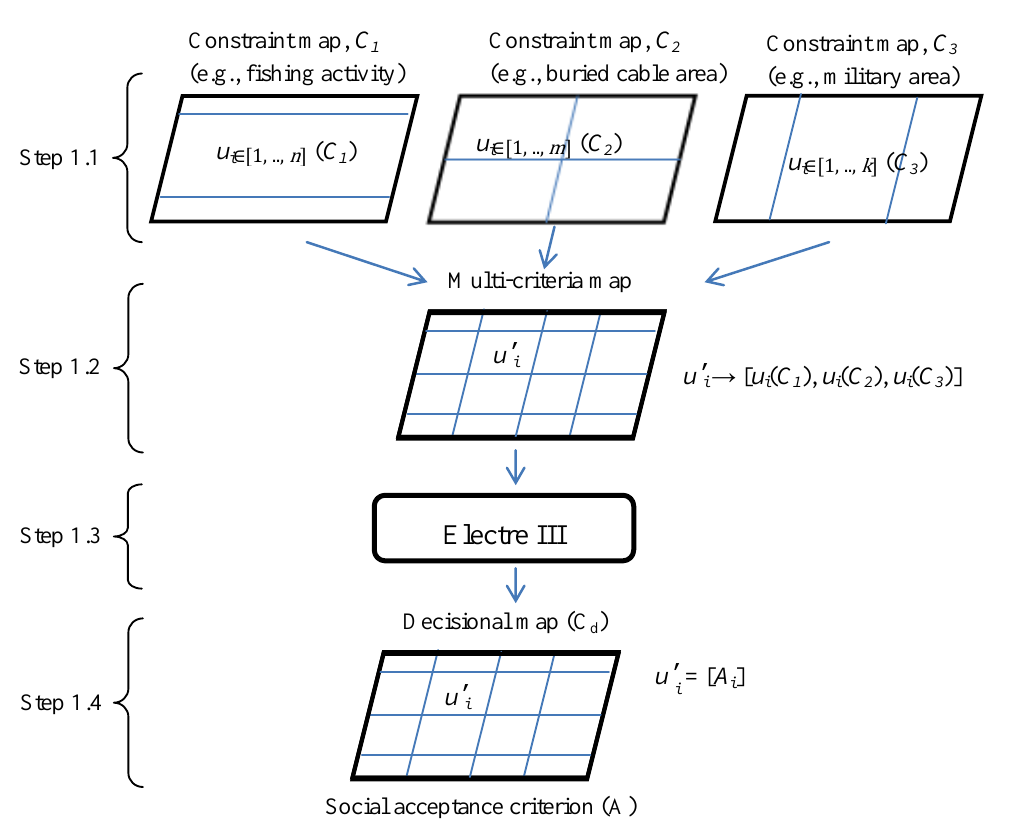
Figure 3. First step of the